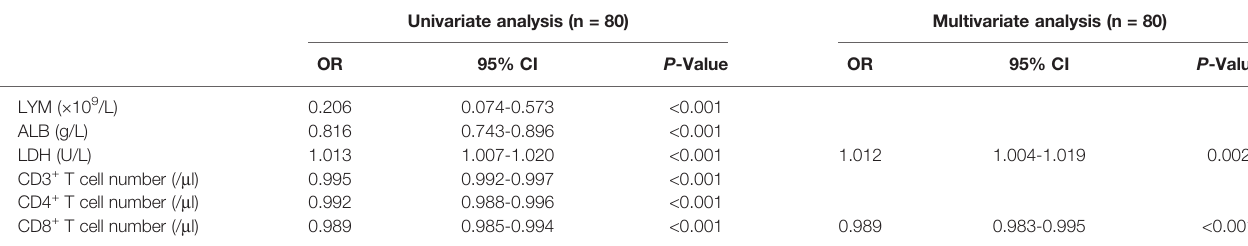
TABLE 4 | Univariate and multivariate analyses of risk factors associated with infection of PJP.